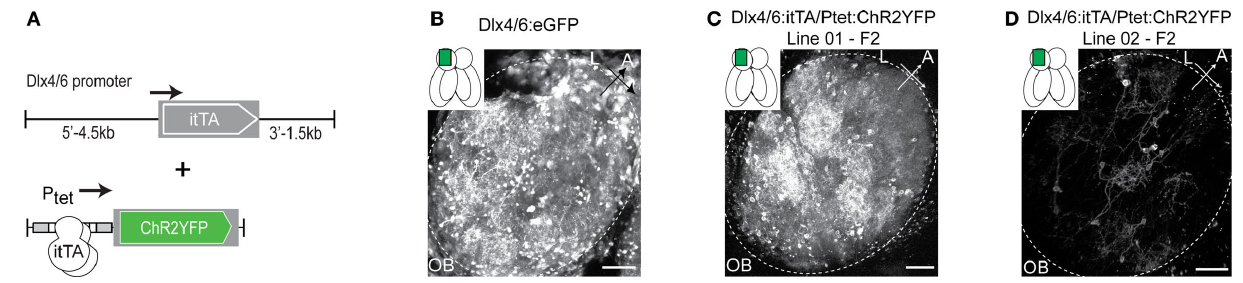
conventional methods. Expression is observed in interneurons in the intermediate layers. (C) Offspring of Dlx4/6:itTA/Ptet:ChR2YFP Line 01 express in many OB interneurons. (D) Offspring of Dlx4/6:itTA/Ptet:ChR2YFP Line 02 express in a sparse subset of OB interneurons. Scale bars: 50 µm.